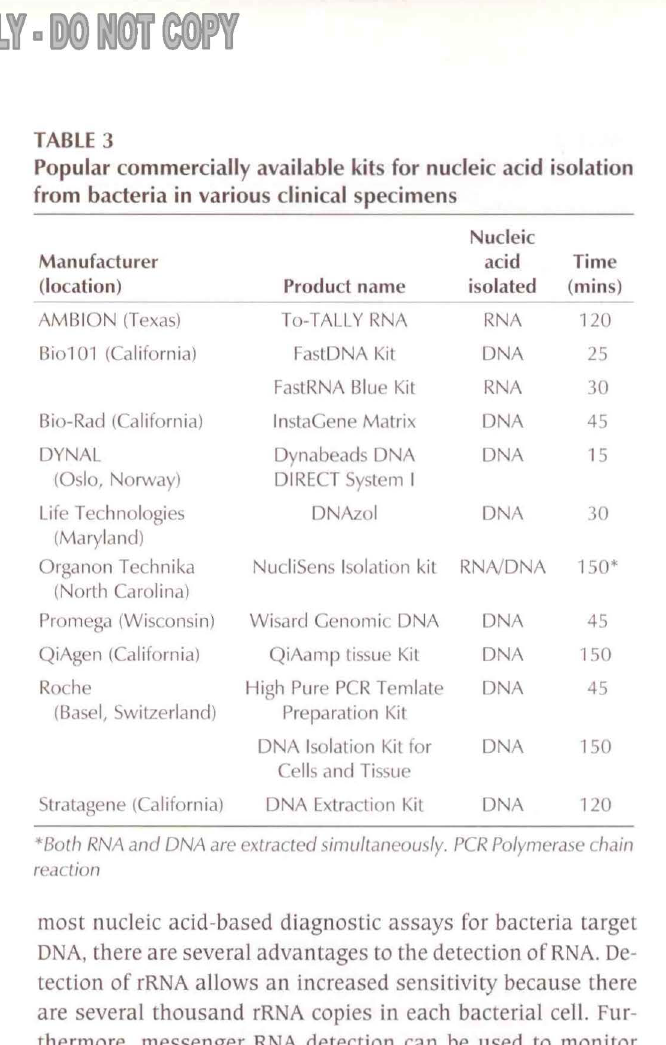
Popular commercially available kits for nucleic acid isolation from bacteria in various clinical